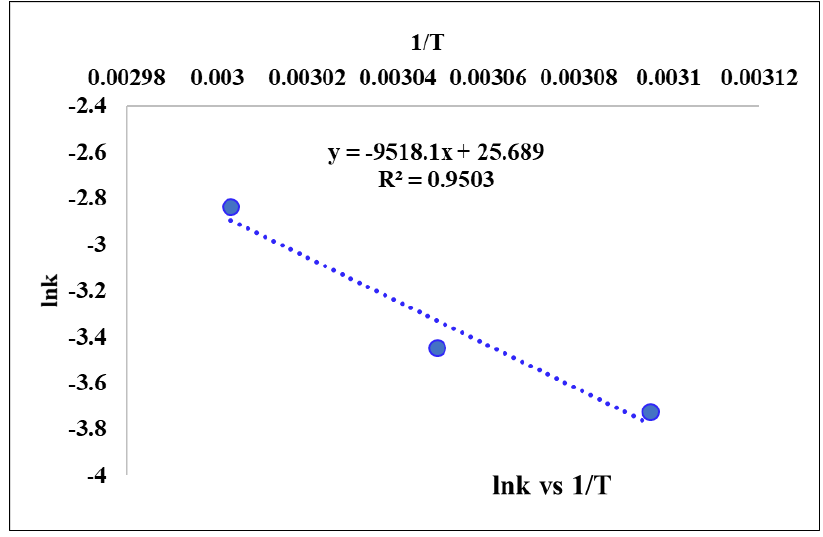
Figure 22. 1/T vs. ln k graph for the activation energy determination of the WCO transesterification process.